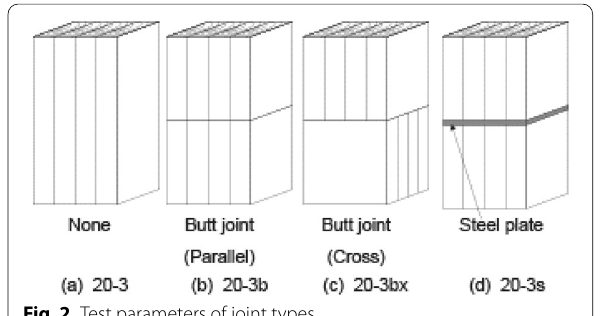
Fig. 2 Test parameters of joint types